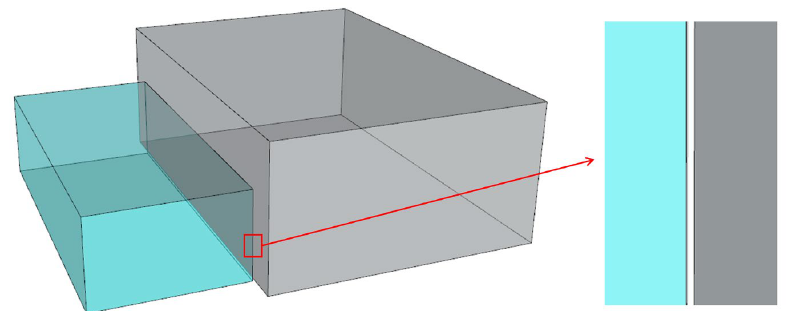
Figure 10. Small gap between components.